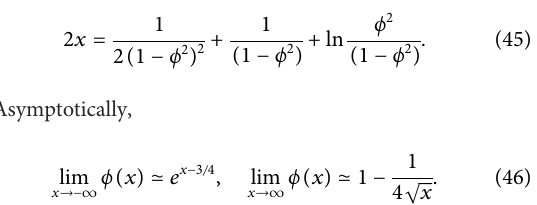
FIGURE 4 Potential given by Eq. 40 with n = 3 ( V 3 ) and n = 4 ( V 4